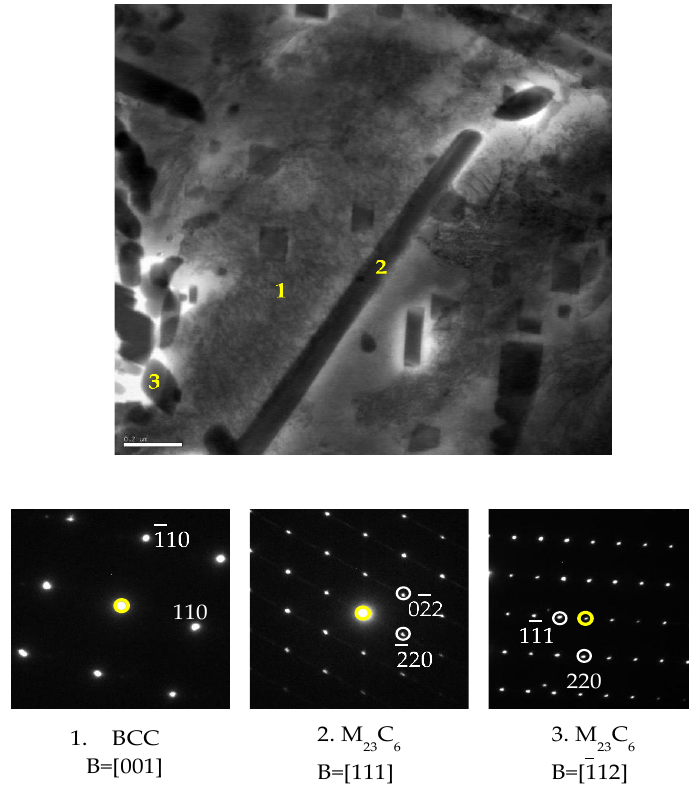
Figure 5. TEM micrograph and diffraction patterns of the particles in the conventionally heat-treated 2124 alloy showing most of the M 23 C 6 carbides and the orientational relationship with the matrix. The micrographs of dendritic and eutectic austenites in conventionally heat-treated conditions are different from each other. As mentioned earlier, dendritic austenite was filled with M 23 C 6 particles, while little or no M 23 C 6 particles existed in the eutectic austen- ite, as displayed in Figures 6 and 7. This means the nature of austenite with a dendrite structure is different from that with a eutectic structure. As Dupin showed schematically, the alloying elements are believed to contribute to forming M 7 C 3 carbide during a eutectic reaction; thus, C and Cr in the austenite enveloping the M 7 C 3 carbides are depleted [3,4]. As the austenite in the dendrite formed before the eutectic M 7 C 3 /austenite reaction, the solute concentration of the austenite in dendrite might be rich compared with that of the eutectic austenite. This means that the primarily solidified dendrites have a high potential to form the precipitates due to saturation of solute elements such as Cr and C. Therefore, easier and more precipitation of M 23 C 6 occurred during destabilization in the dendritic austenite than in the eutectic austenite.